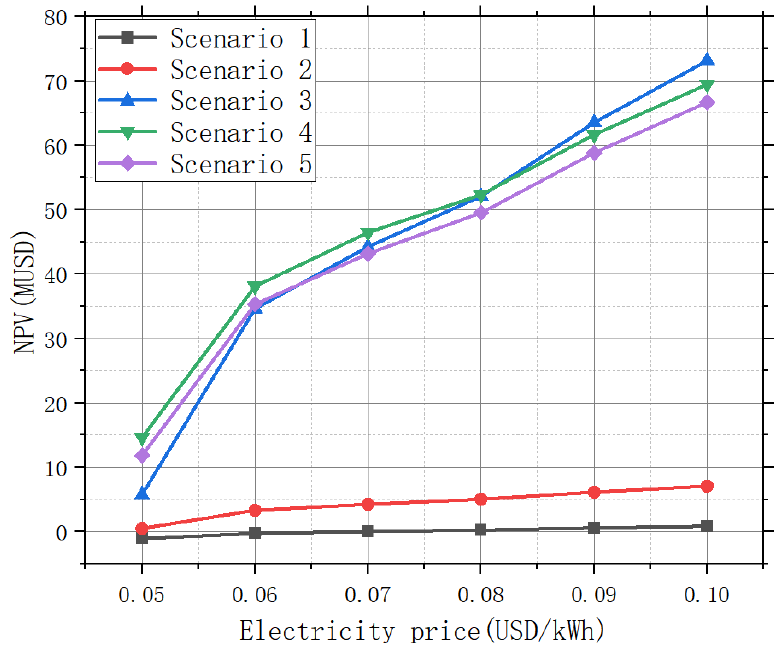
Figure 13. NPV of the model under different electricity prices .